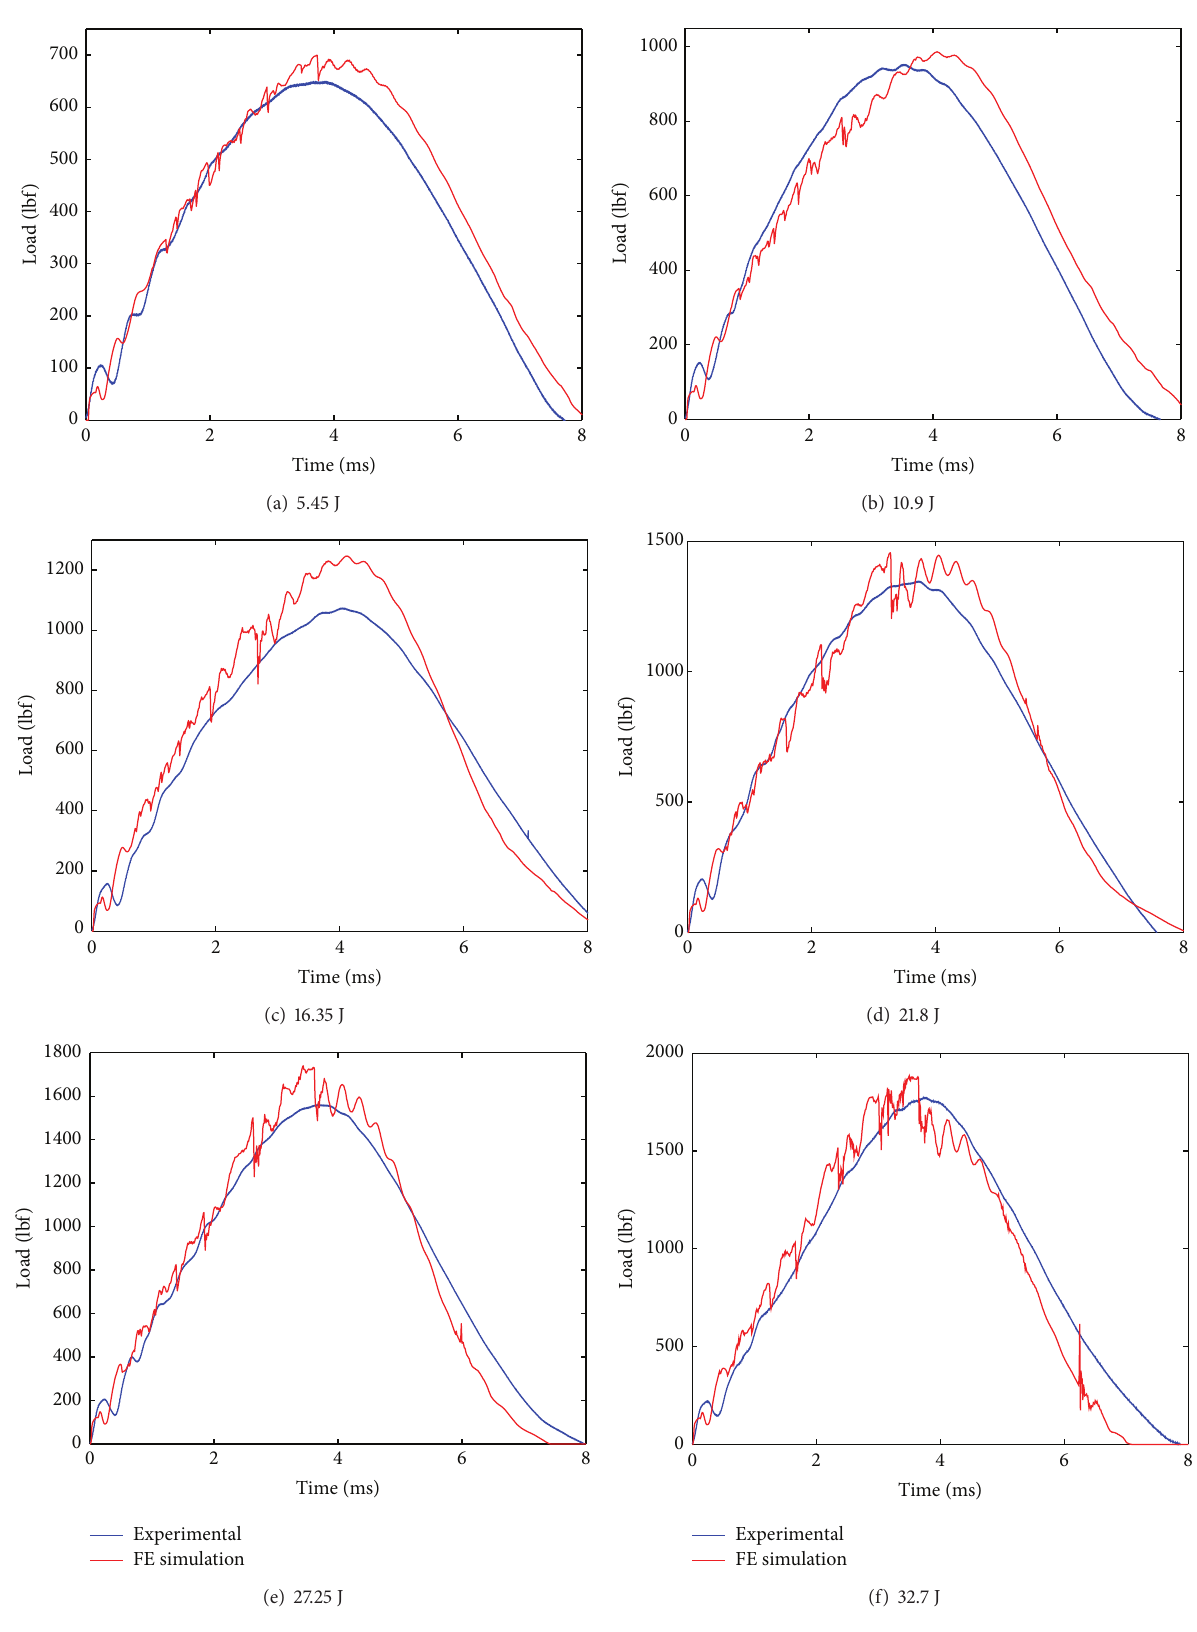
Figure 8: Impact load versus time plots for E Glass/Epoxy laminates at six impact energy